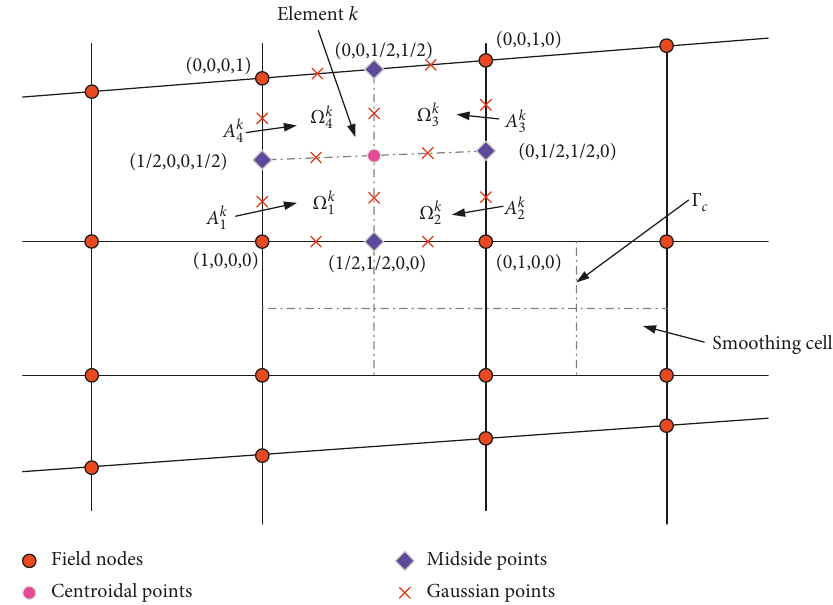
Figure 3: Smoothing subcells and the values of shape